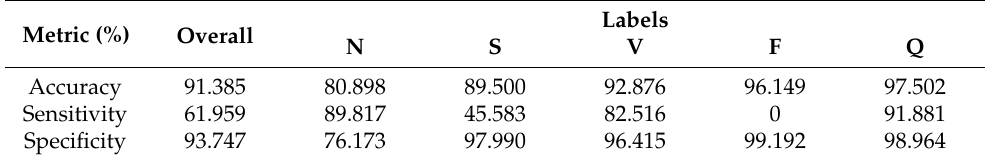
Table 7. Performance metrics of two-phase heartbeat classification on test dataset.